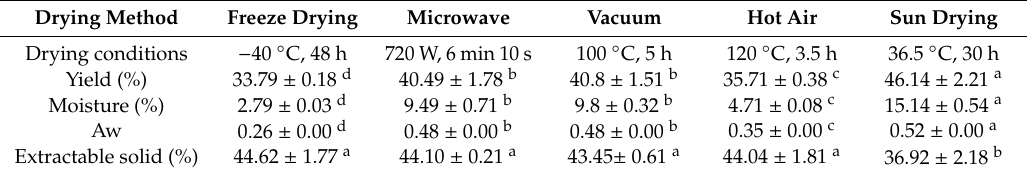
Table 4. Impact comparison of five di ff erent drying methods on physical properties of Tuckeroo fruits. Drying Method Freeze Drying Microwave Vacuum Hot Air Sun Drying Drying